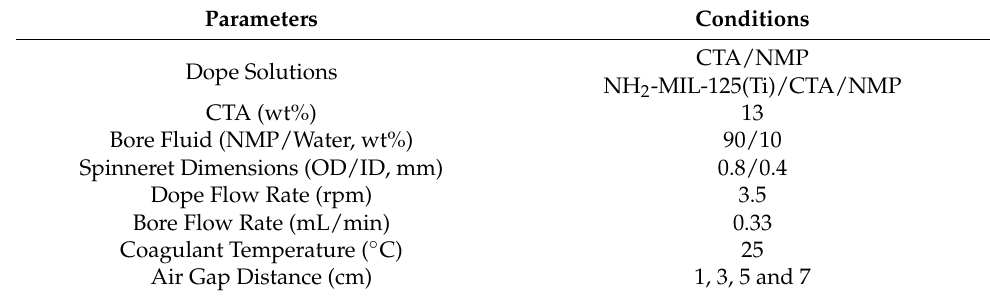
Table 1. Parameters for the spinning of CTA HFM and NH 2 -MIL-125(Ti)/CTA